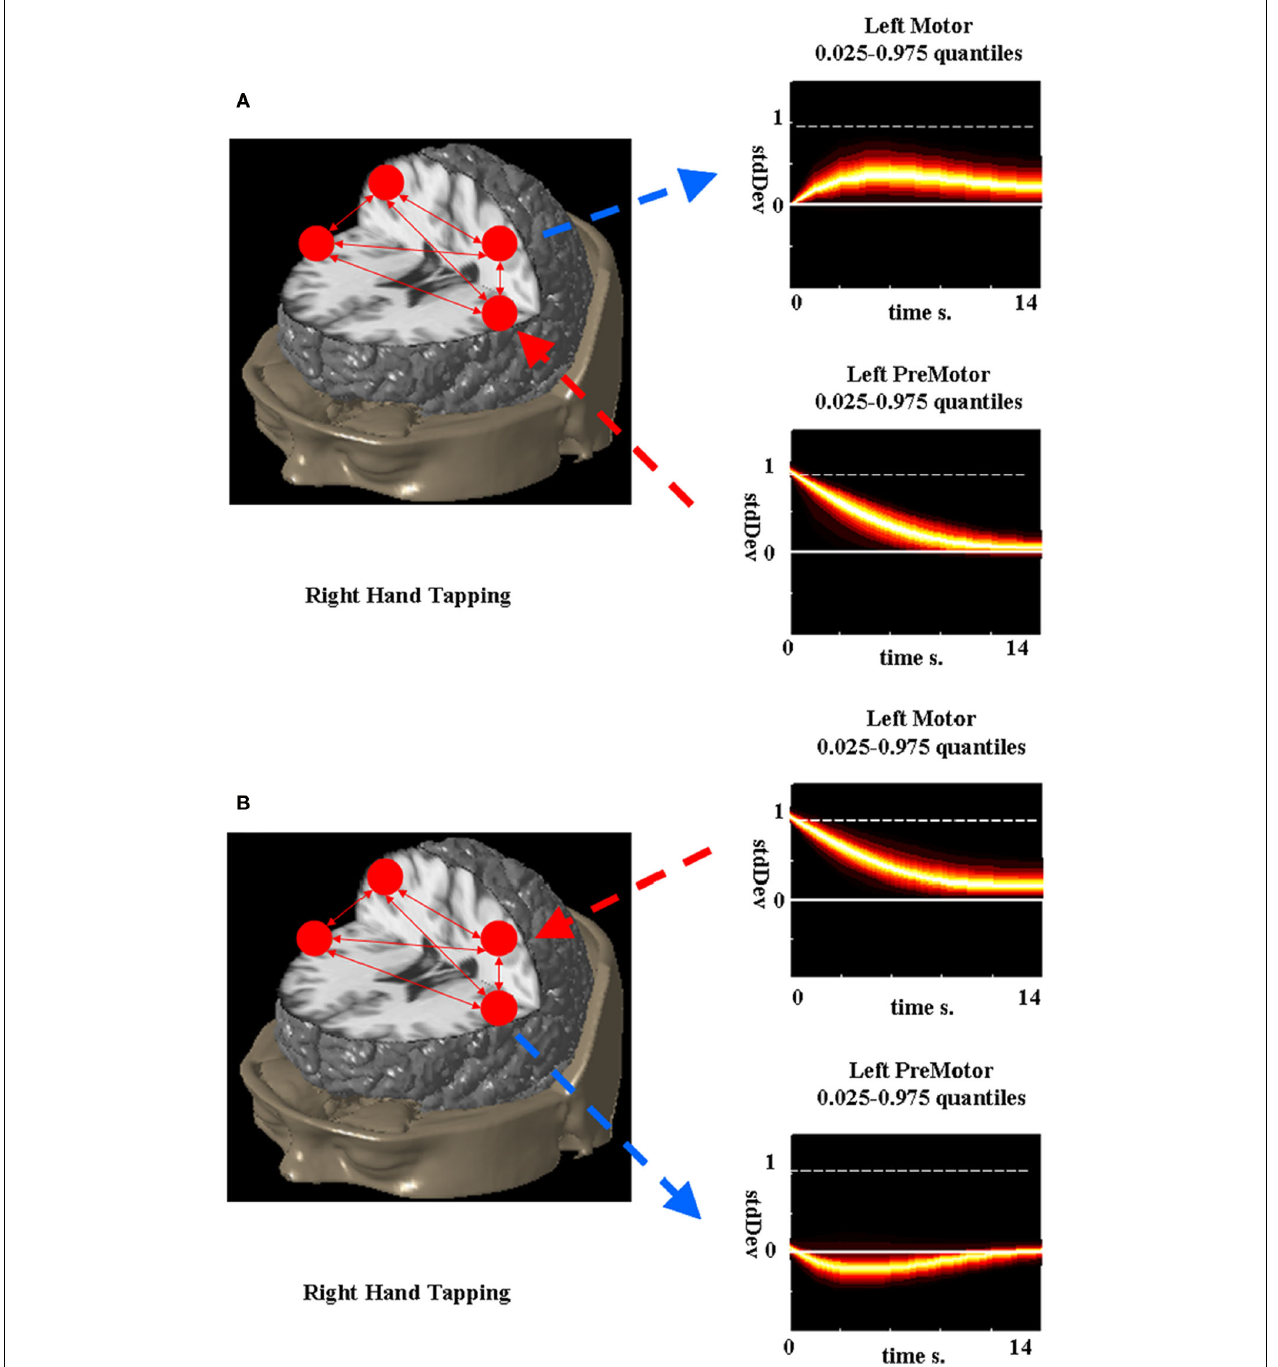
function. A 1 SD impulse to the premotor cortex causes a small but sustained increase in the motor cortex while a 1 SD impulse to the primary motor cortex causes a smaller, less sustained decrease in the premotor cortex.